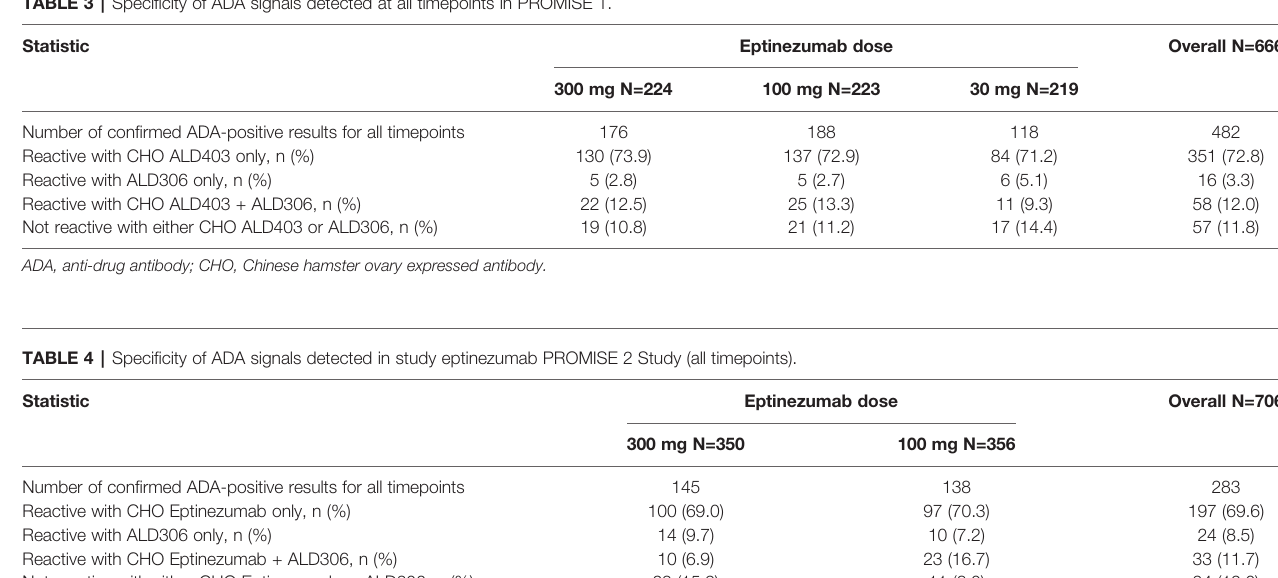
Number of con fi rmed ADA-positive results for all